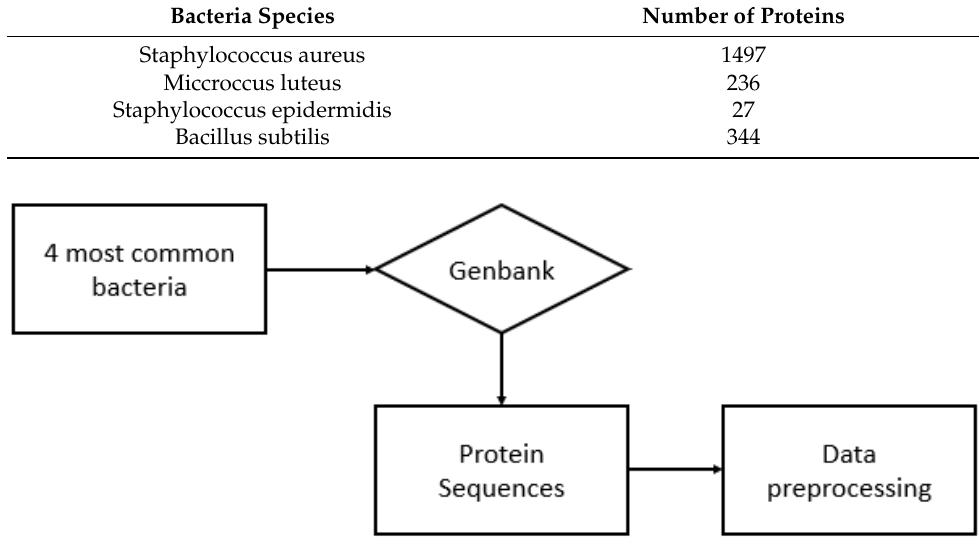
Figure 1. Pipeline for unknown protein data collection.